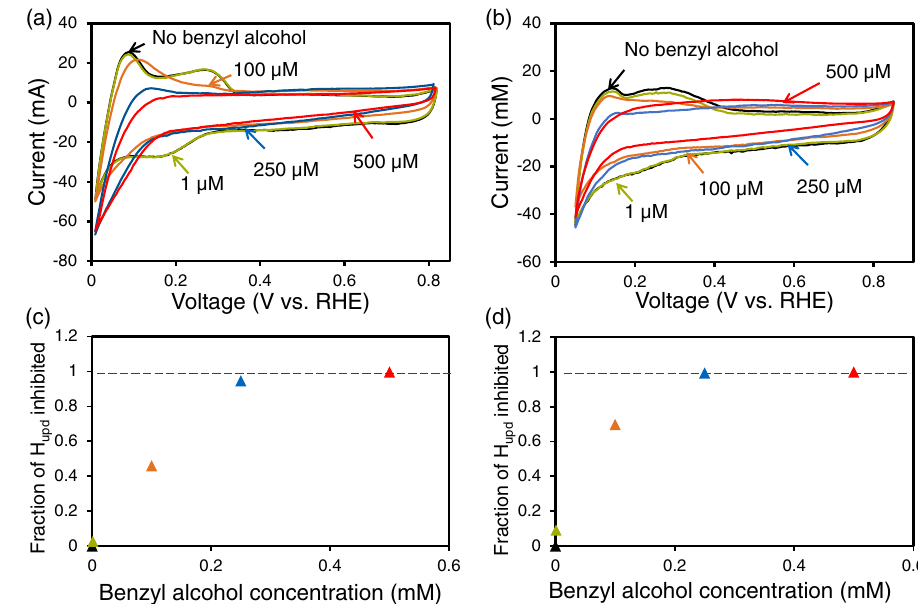
Fig. 2 | In fl uence of the benzyl alcohol concentration on the coverage of H on Pd/C. Cyclic voltammograms at a scan rate of 5mVs − 1 showing hydrogen under- potential deposition on Pd/C (30 wt.%) at room temperature with benzyl alcohol concentration varying from 0 to 500 µ M and at a pH 2.5 in phosphate buffer solution and b pH 5 in acetate buffer solution. The calculated fraction of